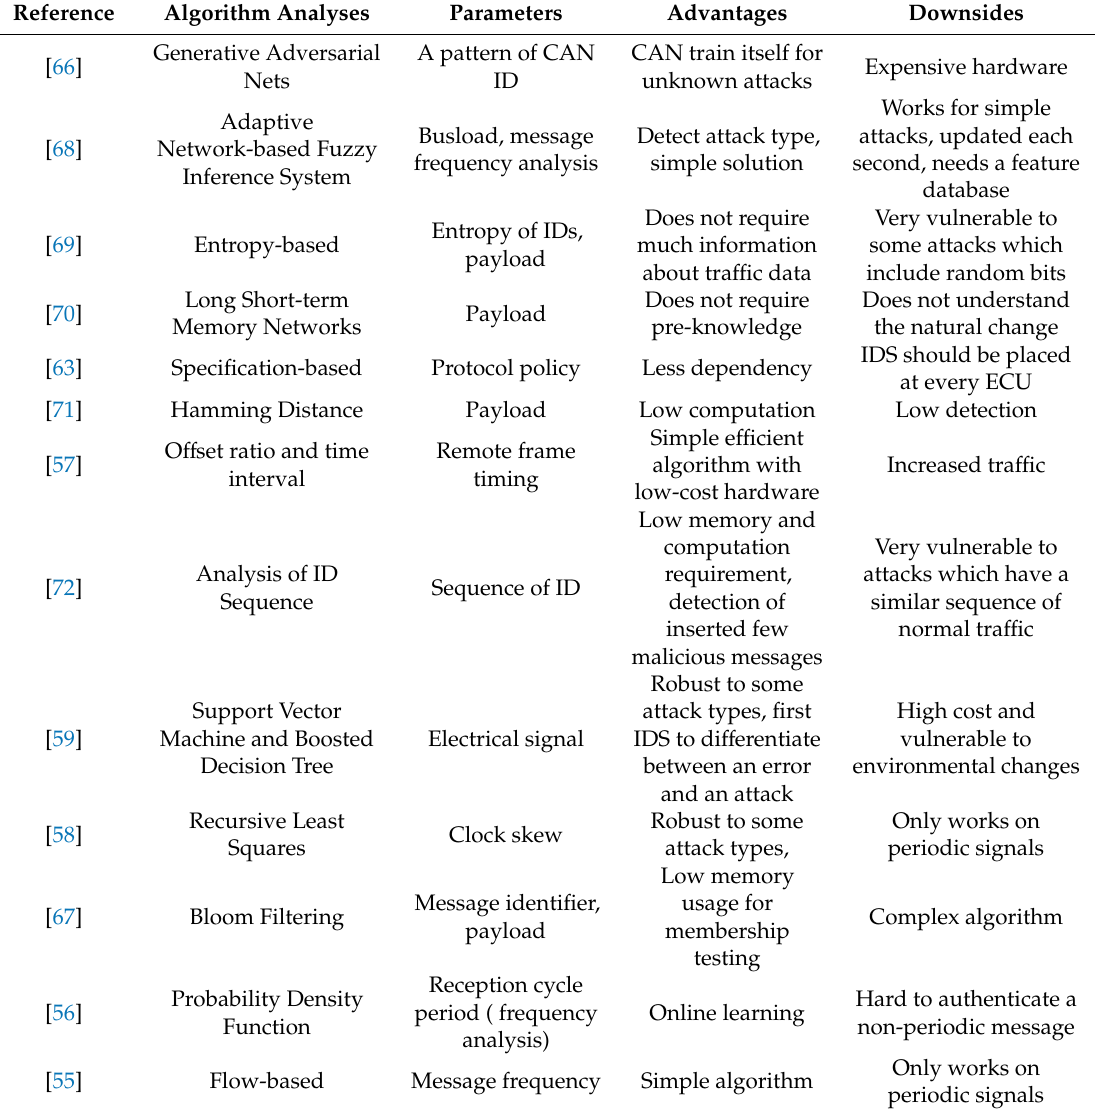
Table 5. Comparison of the intrusion detection system